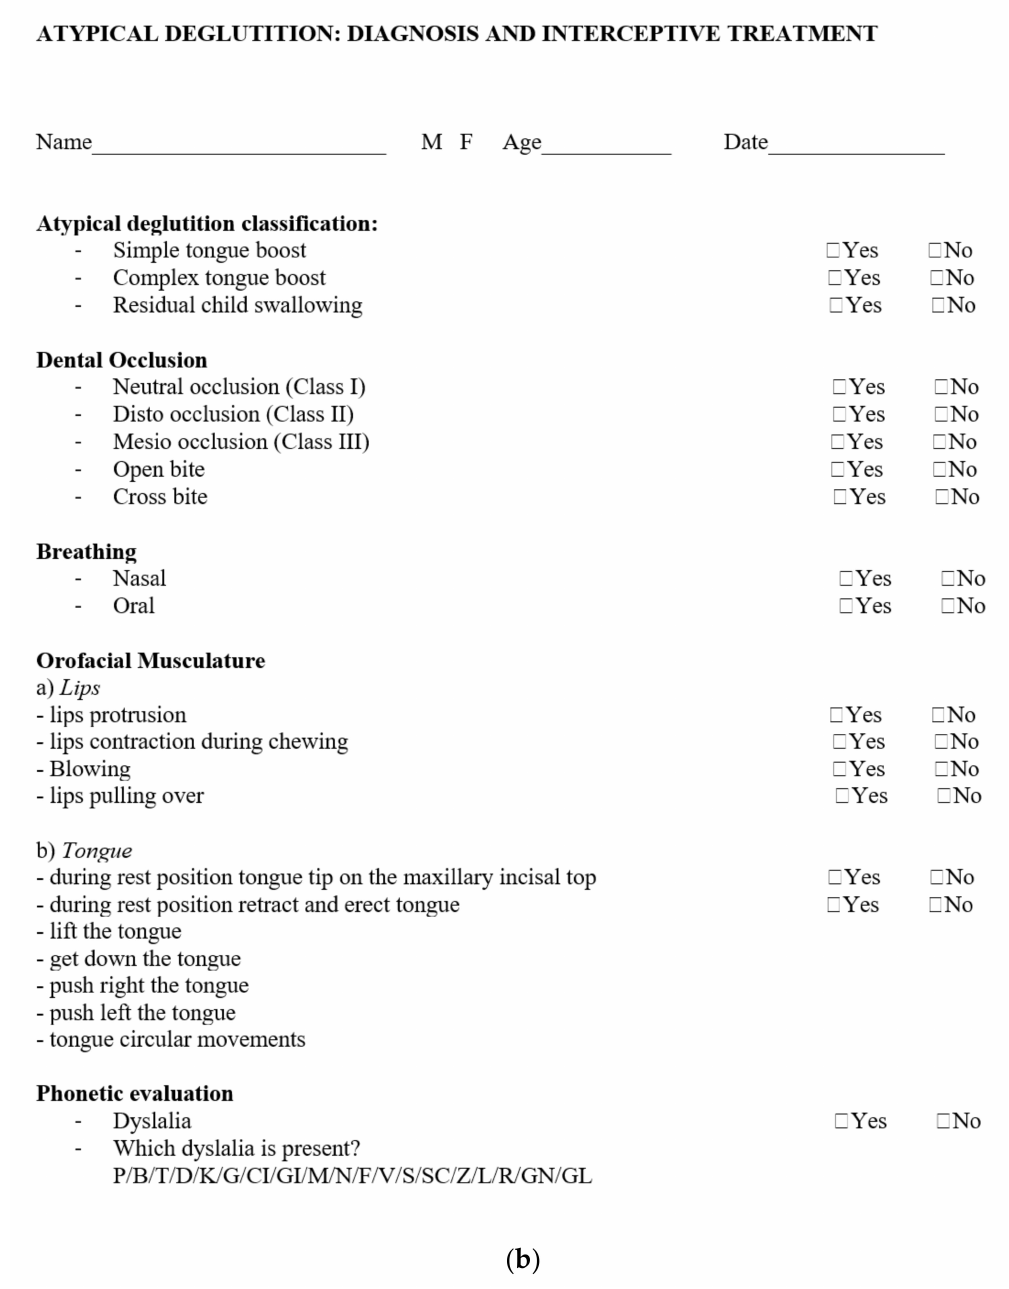
Figure 1. ( a ) Functional tongue analysis—Part 1 ( b ) Functional tongue analysis—Part